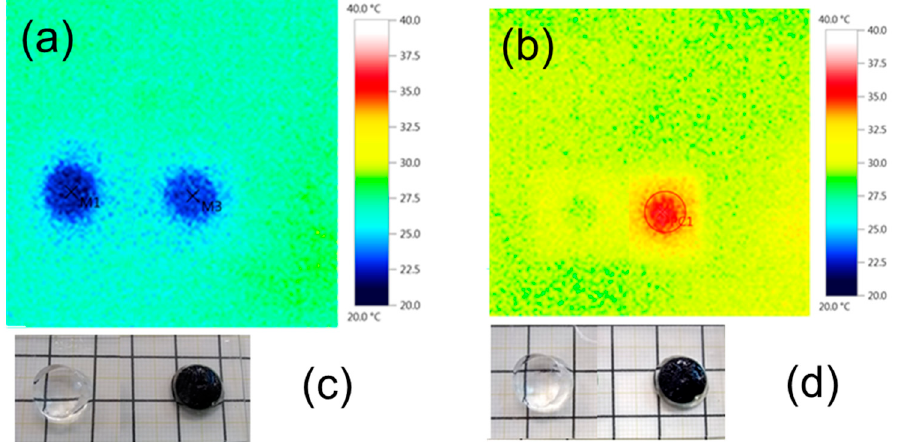
Figure 3. Effect of microwaves on the hydrogel and doped (protonated) nanocomposite. Above: thermographic images taken before ( a ) and after ( b ) application of 5 s of microwave irradiation. The scales at the left of each panel link color with temperatures. Below: optical images taken before ( c ) and after ( d ) application of 5 s of microwave irradiation. The transparent sample (left in ( c , d )) correspond to the hydrogel matrix while the green sample (right in ( c , d )) corresponds to the nanocomposite made by IPH.